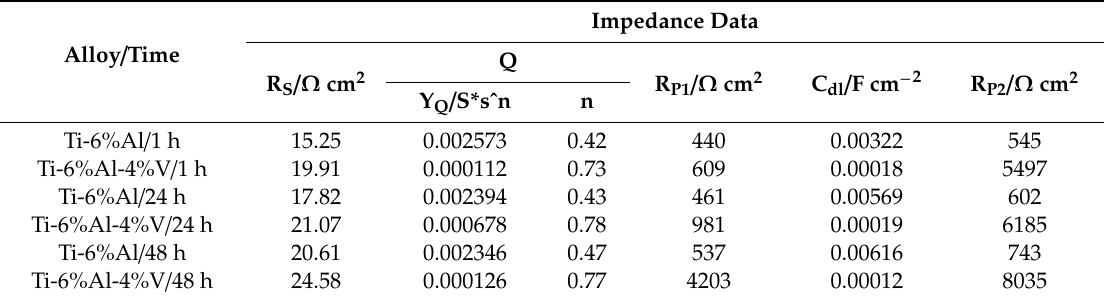
Table 2. Impedance parameters for the tested